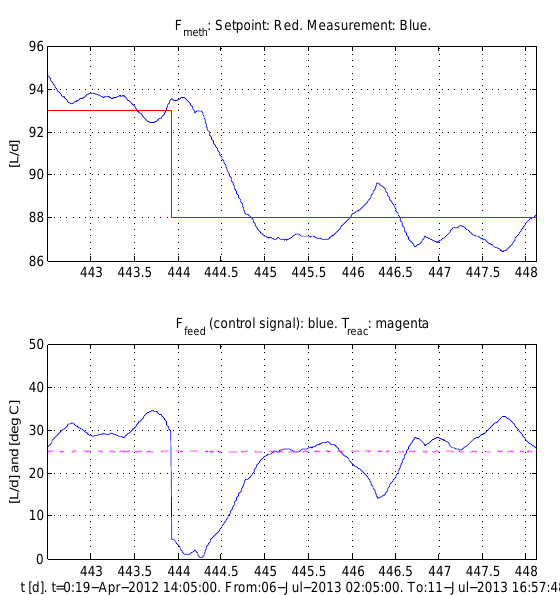
Figure 9: Responses on the real reactor with PI methane flow controller tuned with Skoges- tad’s